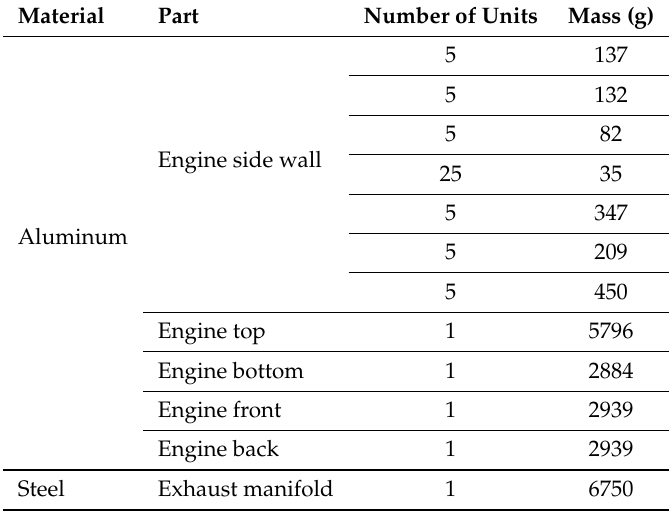
Figure 3. The simplified engine with indicated locations of thermocouples from the experiment. Table 2. Properties of thermal masses used to represent the simplified engine and the exhaust